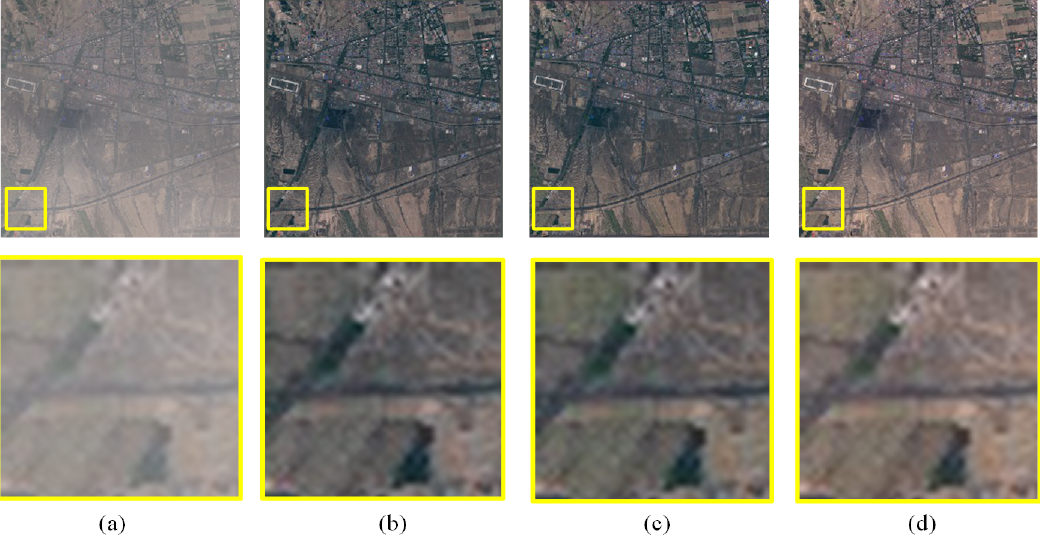
Figure 10. The thin cloud removal results of a Sentinel-2A sample reconstructed with different fidelity losses: ( a ) input cloudy image, ( b ) reconstructed image with the (cid:96) 2 loss, ( c ) reconstructed image with the (cid:96) 1 loss, and ( d ) reference cloud- free